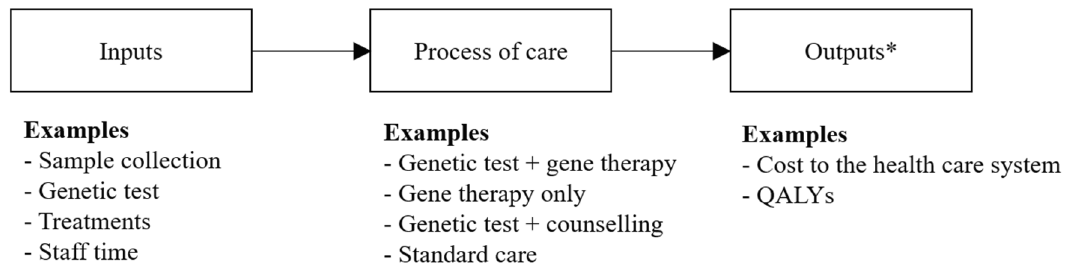
Figure 1. Link between Health Care Inputs, the Process of Care, and Outputs Relevant to Decision- makers. * Outputs are consistent with the perspective of the analysis (e.g., a health care system perspective), measured over the duration of the time horizon (e.g., a lifetime time horizon), and discounted to their present